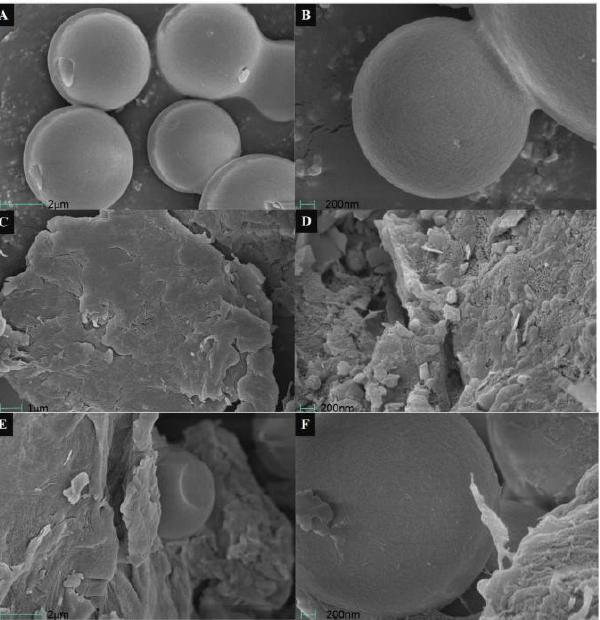
Figure 2. SEM images of SBA-15 ( A , B ); CS 2 − chitosan ( C , D ); CS 2 C@SBA − 3 ( E , F